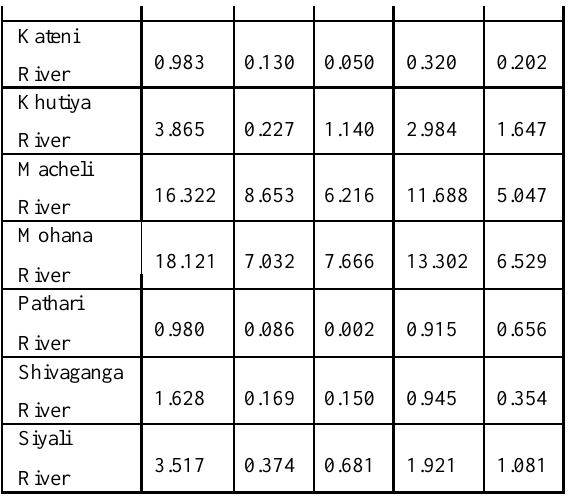
Table 2: River wise Sand Cover (2009-2017)